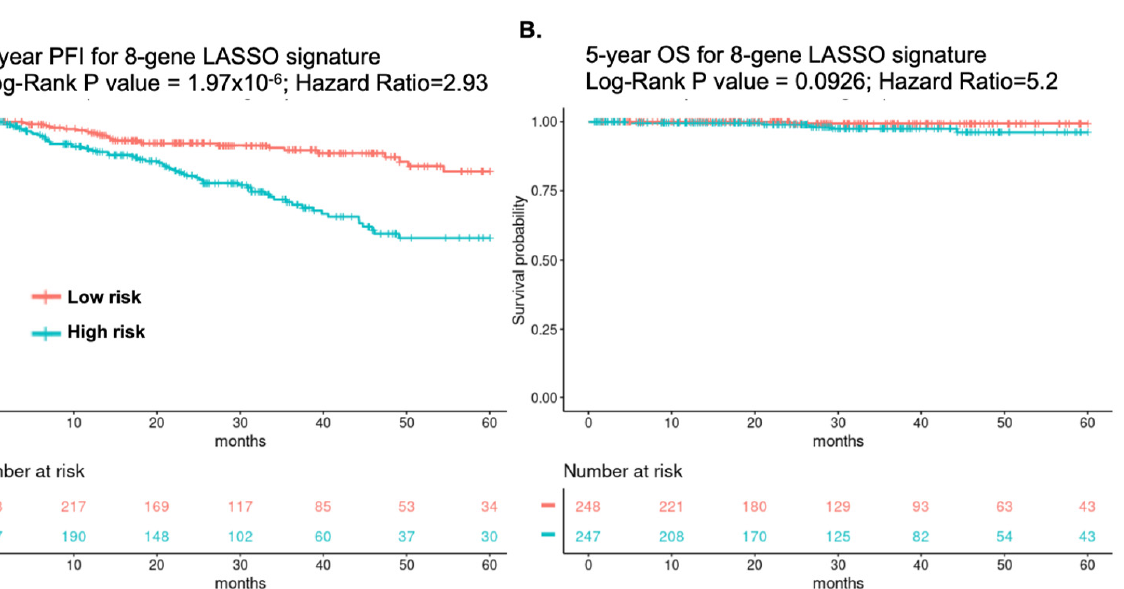
Figure 2. Progression-free interval (PFI) and overall survival (OS). Kaplan–Meier curves for ( A ) 5-year progression-free interval and ( B ) 5-year overall survival of the 8-gene signature. Patients were dichotomized into the “Low risk” group and the “High risk” group according to the 8-gene signature scores. The number of patients of the two risk groups in different following time in month were shown in the bottom tables of KM plots,